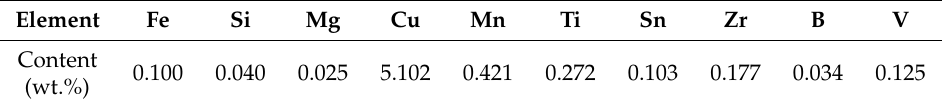
Table 1. Chemical composition of the raw material.